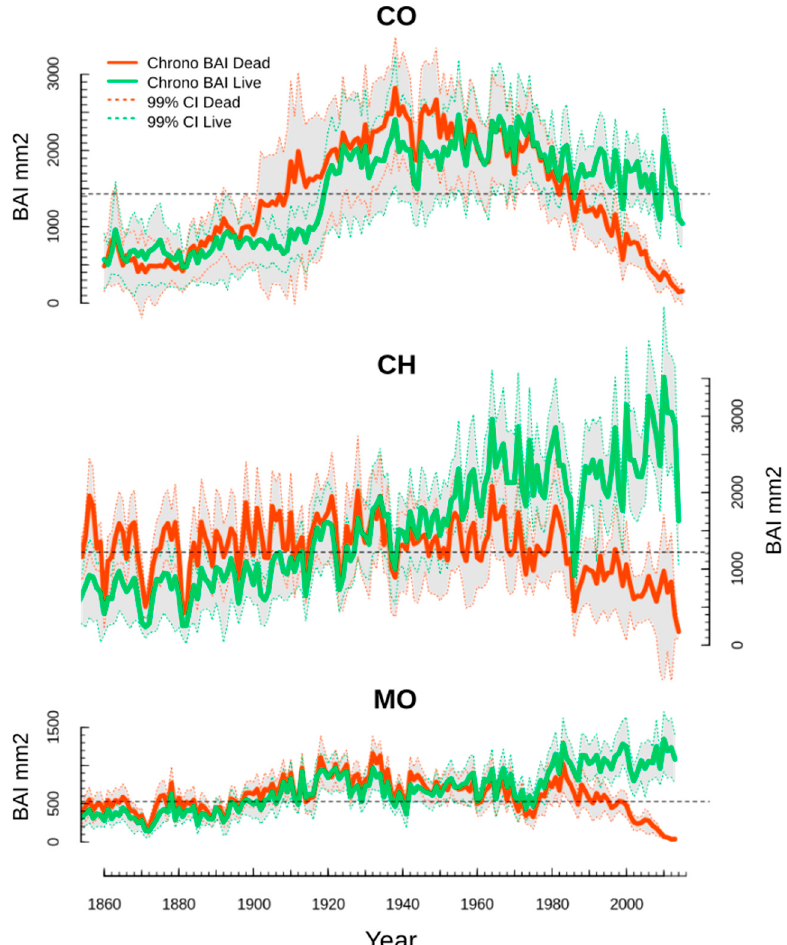
Figure 3. Basal area increments (BAI) chronologies from dead and living trees for the selected three sites (solid lines) and 99% confidence intervals (gray polygons and dotted lines). Horizontal dashed lines represent the mean BAI value for each chronology.